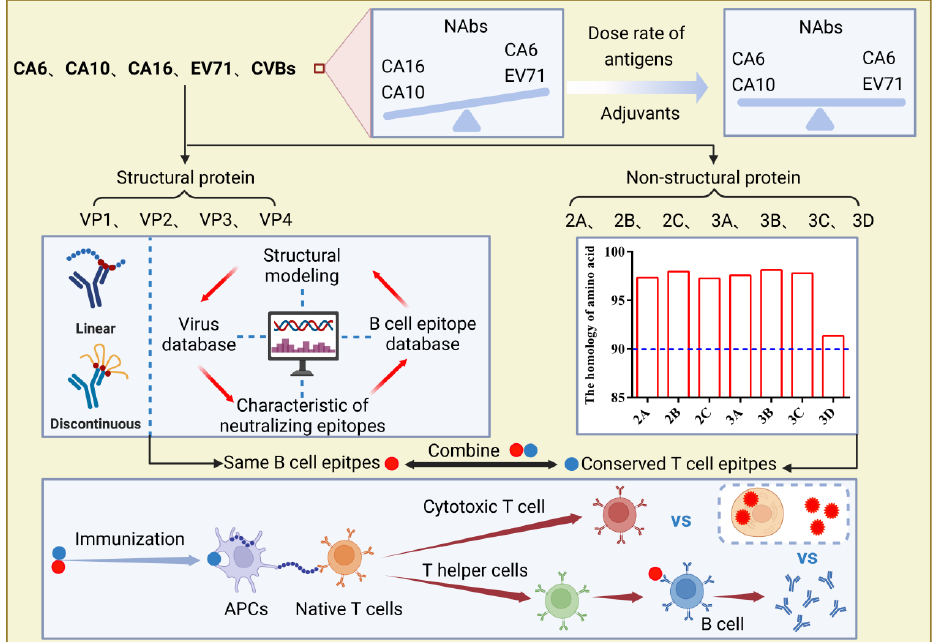
Figure 4. A series of potential methods to get more balanced immune responses and a broader spectrum of protective immune responses in development of multivalent HFMD vaccines. Image created with BioRender (https://biorender.com/, accessed on 10 October